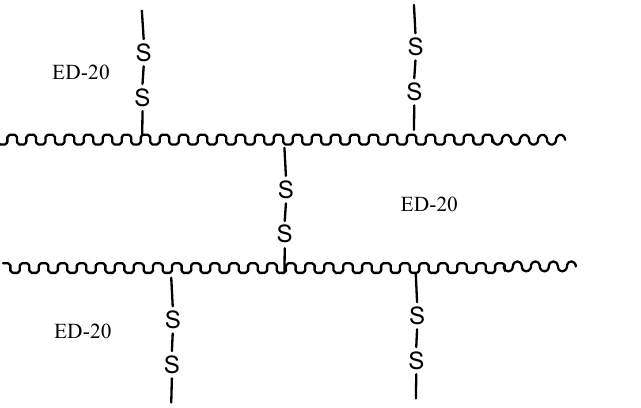
Scheme 1. Crosslinking of NBR with sulfur. ED-20 molecules exist inside the crosslinked network; i.e., the structure shown in Scheme 2 is formed.